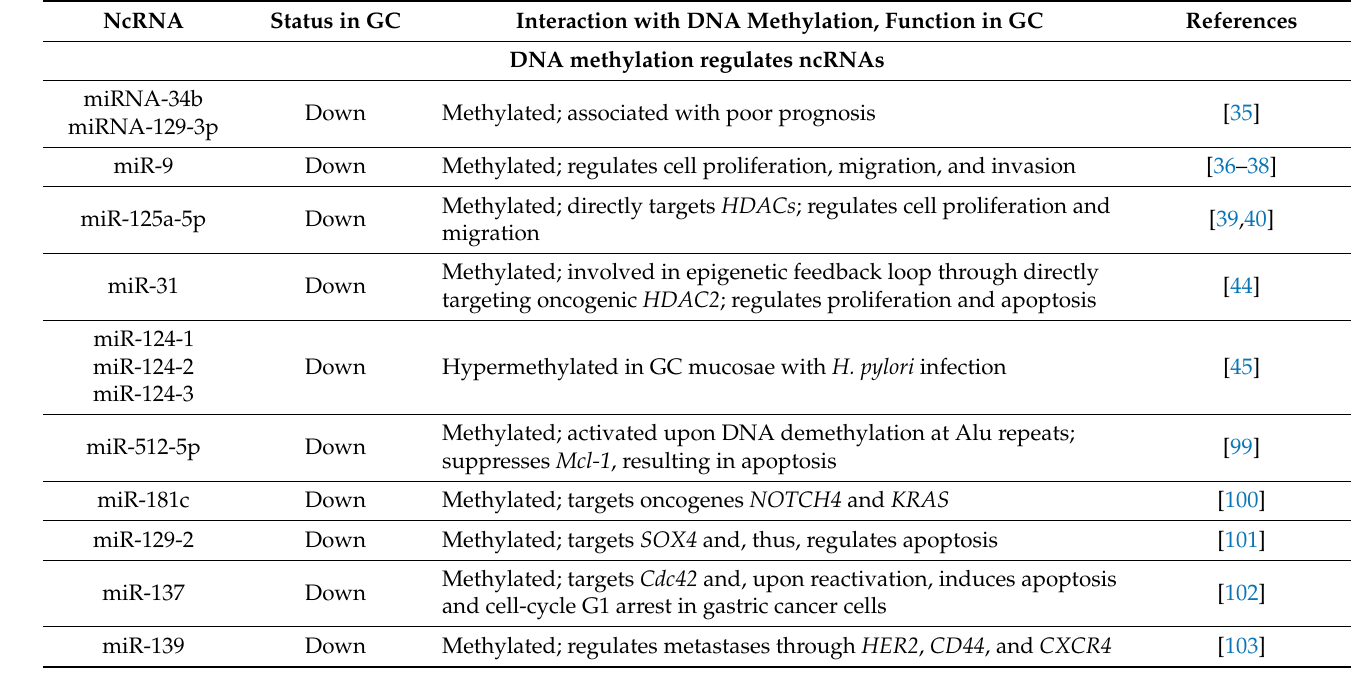
Table 1. Mutual epigenetic regulation of ncRNAs and DNA methylation in GC. Interaction with DNA Methylation, Function in